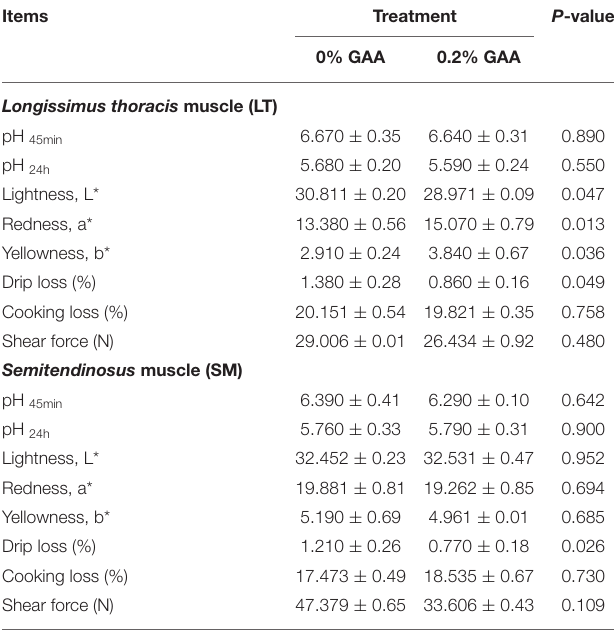
TABLE 6 | Effects of dietary GAA on the meat quality of the LT and SM muscles of Jinjiang bulls.